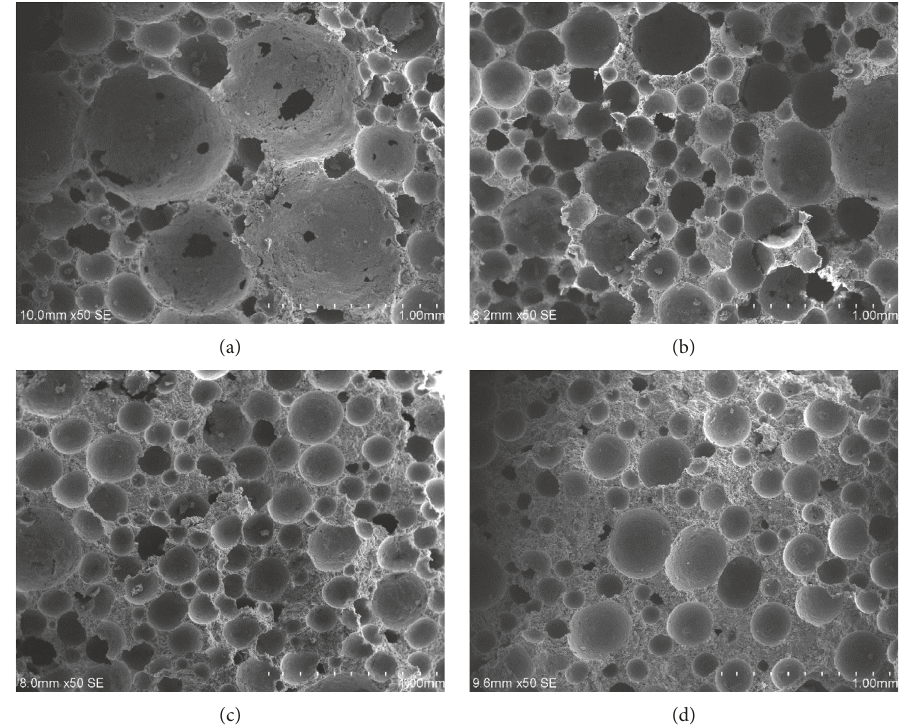
Figure 9: SEM images of FMLSB samples at a 50x magnification. (a) Level 1 (foam content � 750L/m 3 ). (b) Level 2 (foam content � 600